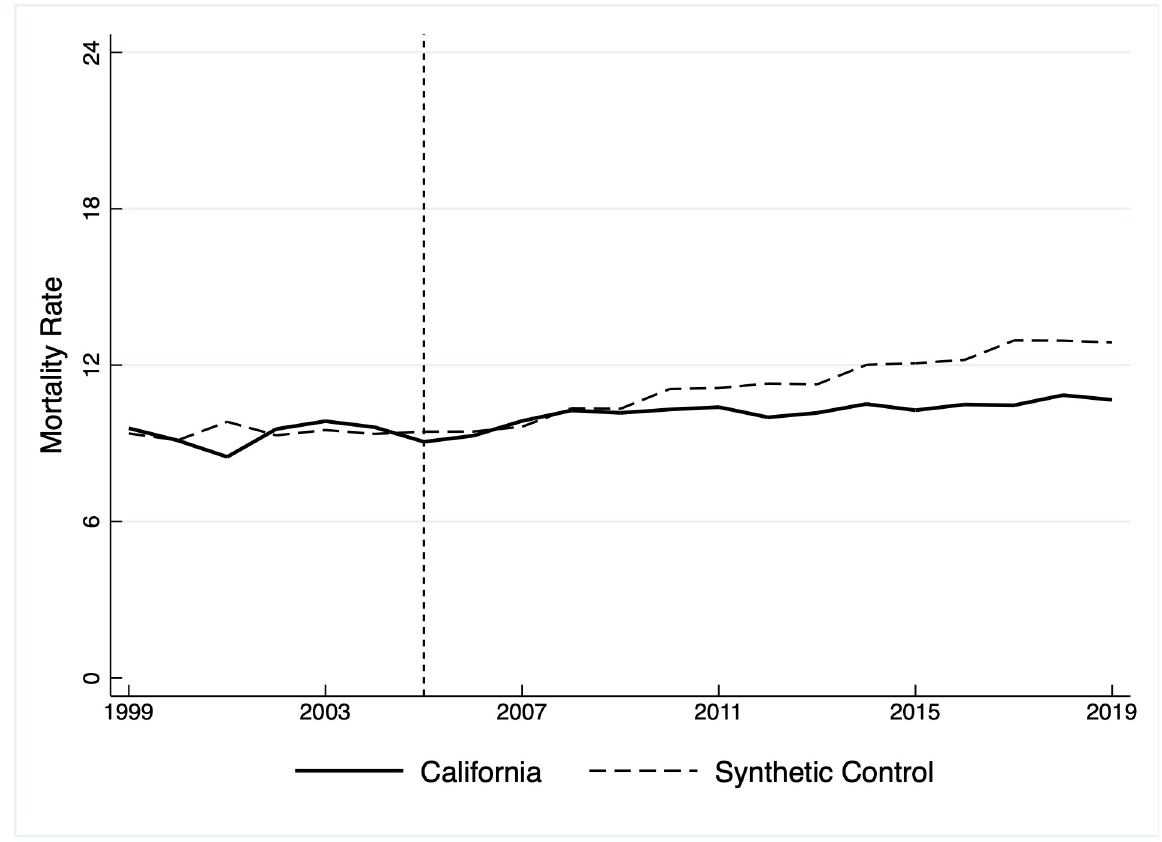
Fig 2. Age-adjusted suicide mortality rate for California’s general population,